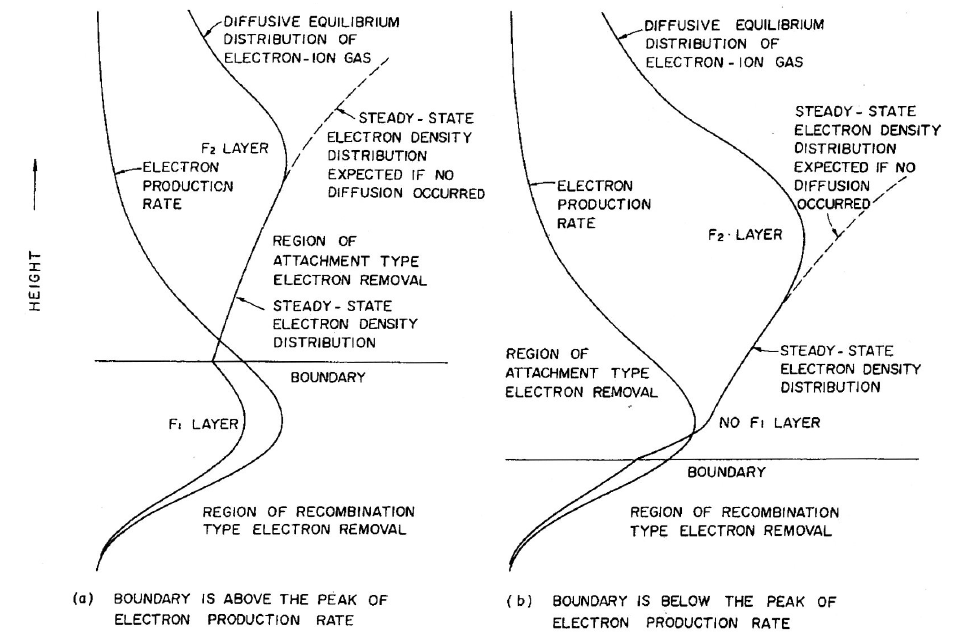
Figure 8. Schematic illustrations of the height distribution of the electron density. See text. (With kind permission from Springer Sci- ence + Business Media: Space Sci. Rev., Theory of formation of the ionosphere, 5, 1966, 3–56, Yonezawa, T., Fig.